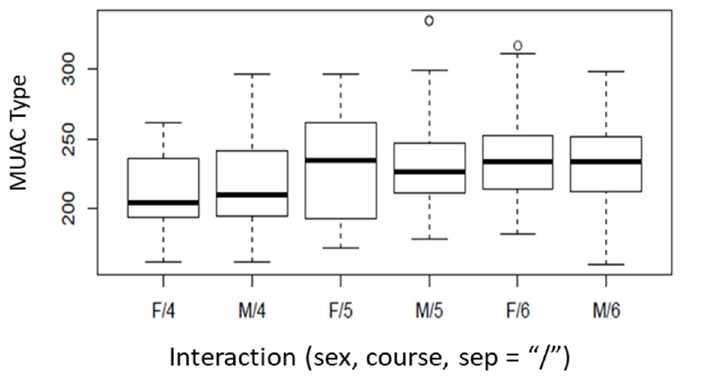
Figure 3. Boxplots of MUAC type by sex and course. “a”—“1” “b”—“2” “b”—“2”. F = female; M = male; 4: 4th course (9–10 years); 5: 5th course (10–11 years); 6: 6th course (11–12 years). “a” and “b” show statistically significant differences between sexes; “1” and “2” show statistically significant differences between courses. MUAC Type: millimetres.